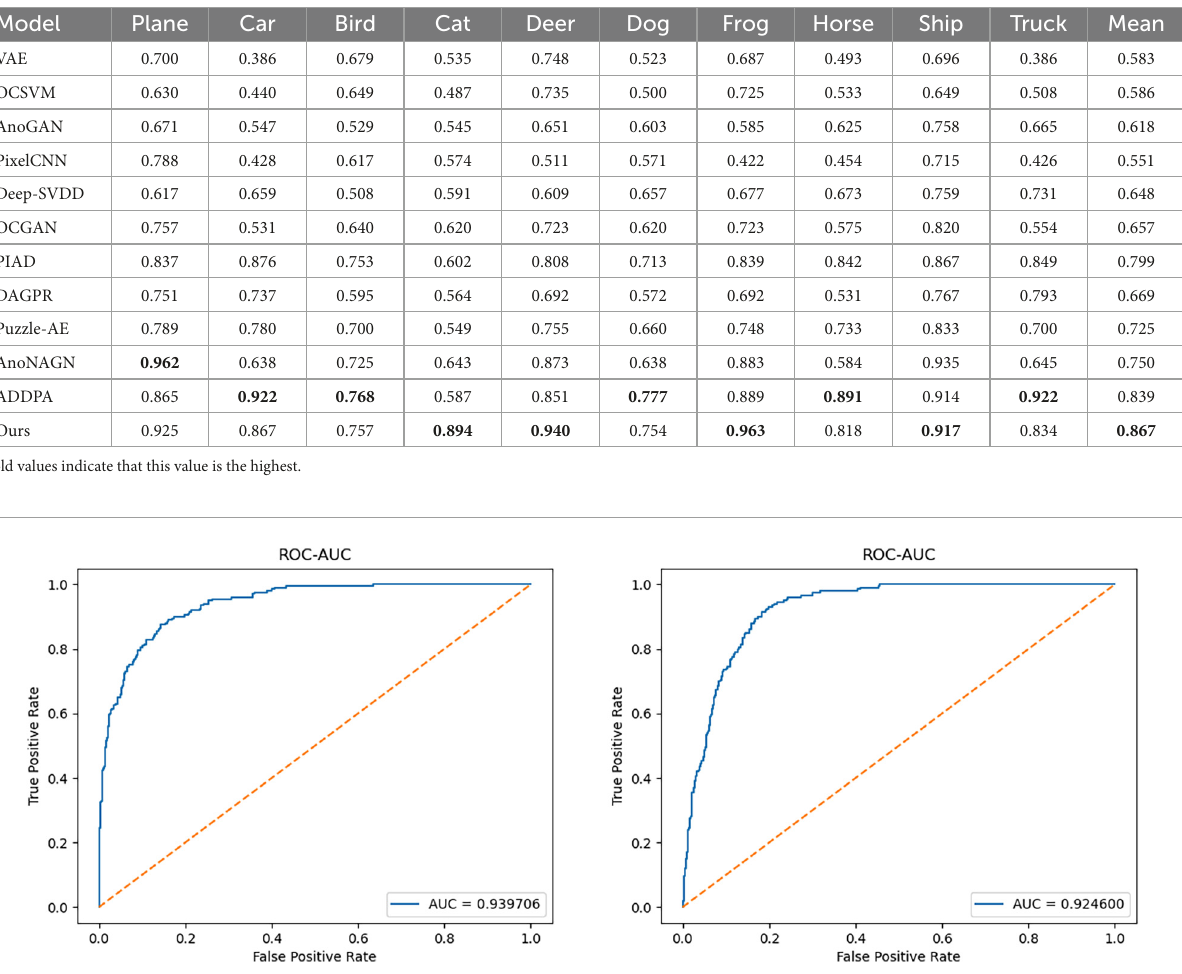
FIGURE5 The ROC curve of the model in the plane and deer categories in